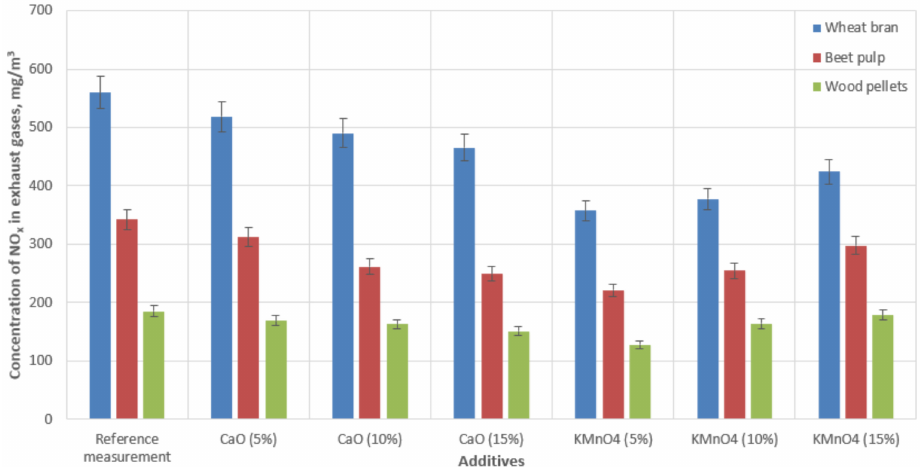
Figure 5. Concentrations of nitrogen oxides in the flue gas of a low-power boiler during the process of burning biomass with catalytic